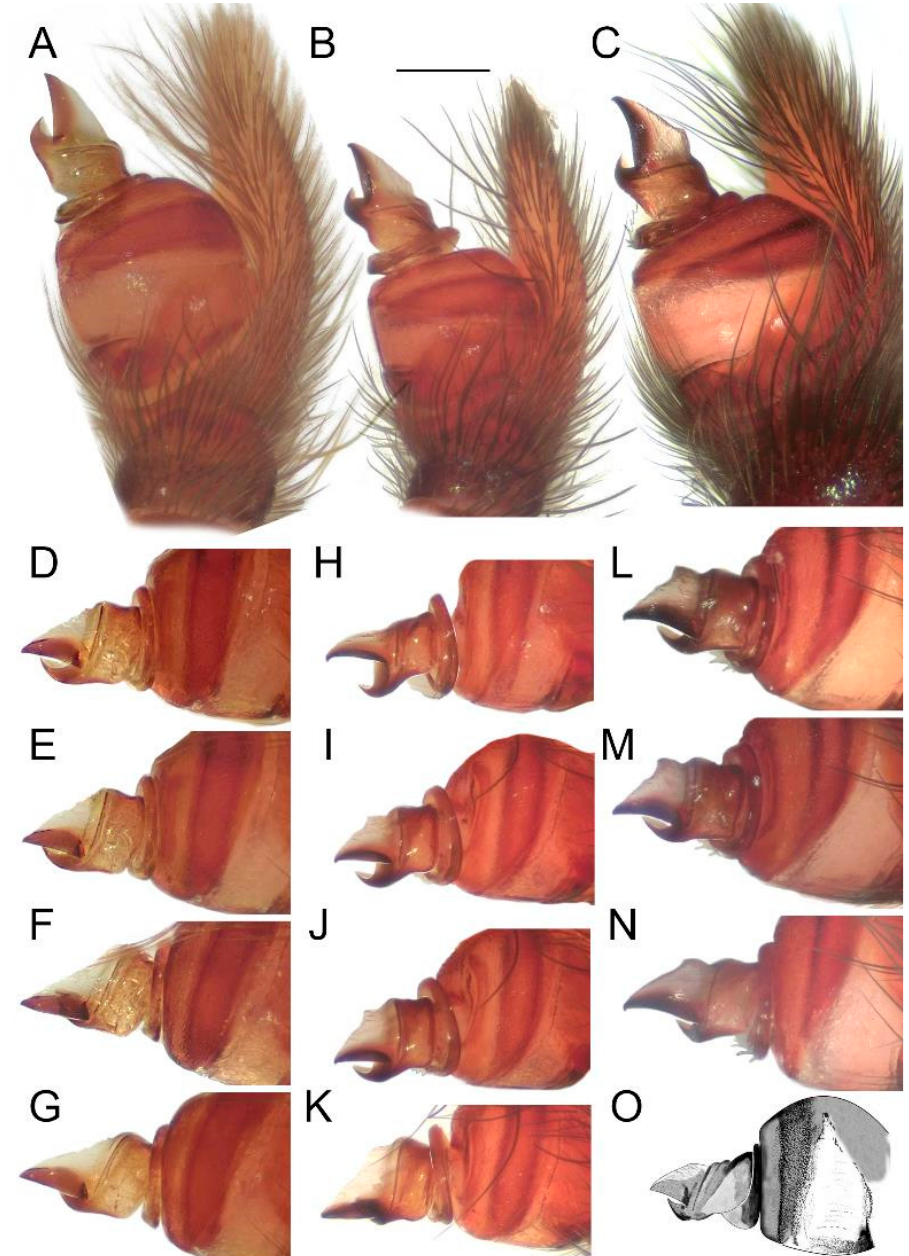
Figure 14. Effect of the angle on the perceived shape of the conductor in Loureedia maroccana Gál et al., 2017 (retrolateral views) ( A – N ). ( A , D – G ) non-type specimen; ( B , H – K ) paratype specimen; ( C , L – N ) fresh specimen; cymbial tip gradually turned in ( D – G , H – K, L – N ). ( O ) Male palp of Loureedia lucasi (Simon, 1873) (retrolateral view), redrawn based on Henriques et al. [3]. Scale bar: 0.25 mm.